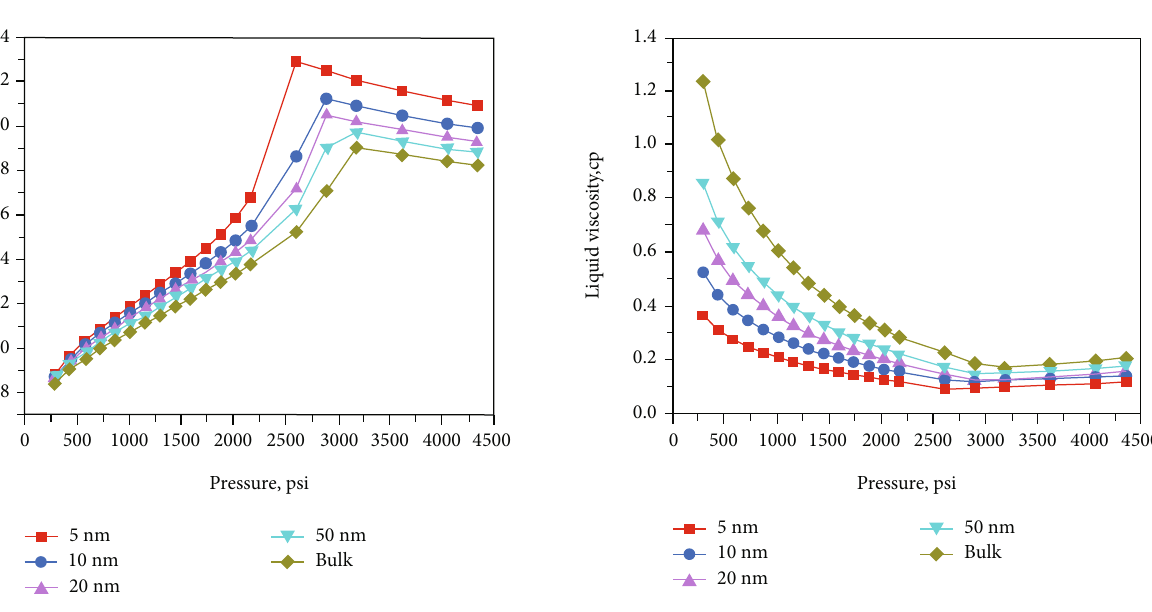
Figure 13: Oil volume factor of the Bakken tight oil versus pressure at various pore radii at T = 230 ° F.